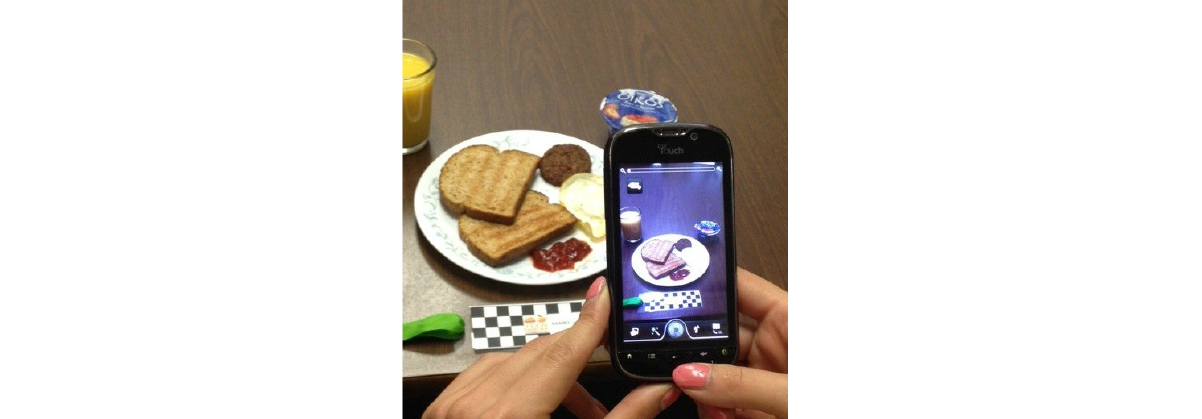
Figure 2. Image of the food setting with the fiducial marker (FM). The participant captures the entire food setting at one step away from the edge of the table. The height of the mobile phone camera above the setting (~1 foot) is first determined using the ribbon on the FM. When stepping back, elbows are clipped to one's sides to maintain position of the arms. Keeping the arms steady, the mobile phone camera is tilted up or down until the whole setting can be seen on the